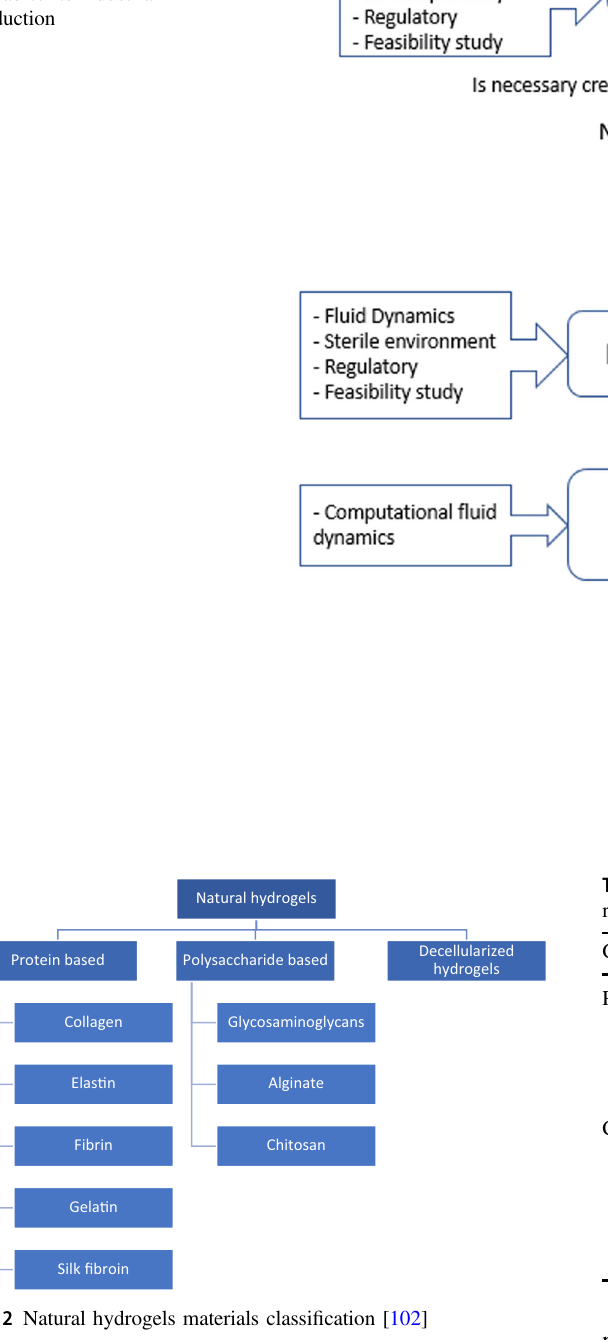
Fig. 1 Diagram of the process from the hydrogel obtention in the lab to its industrial